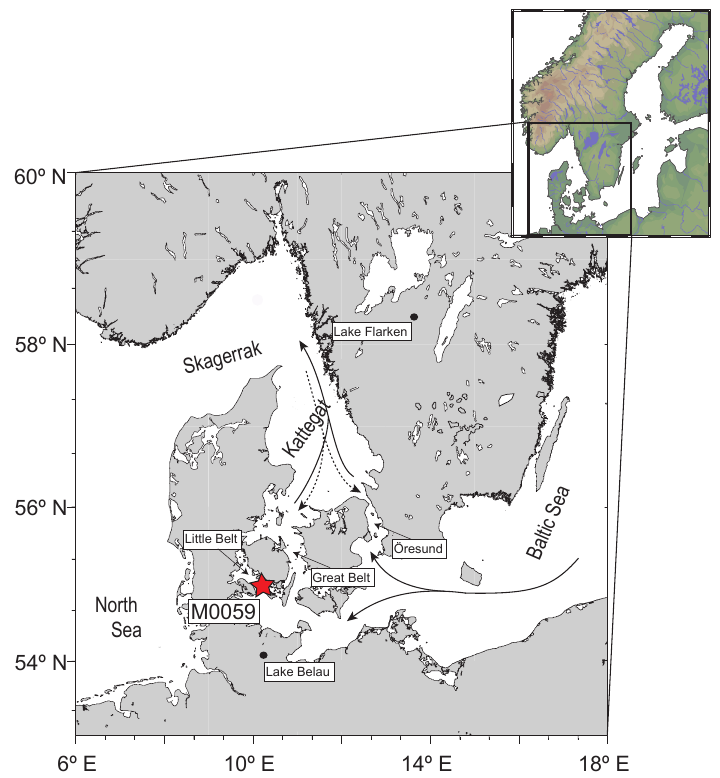
Figure 1. Map of the southern Baltic Sea (redrawn from Groeneveld and Filipsson, 2013). The positions of IODP Site M0059 (red star; 55 ◦ 0.29 (cid:48) N, 10 ◦ 6.49 (cid:48) E; Andrén et al., 2015a), Lake Belau (Dörfler et al., 2012), and Lake Flarken (Seppä et al., 2005) are indicated. Contin- uous (surface) and dashed (bottom) lines indicate dominant current